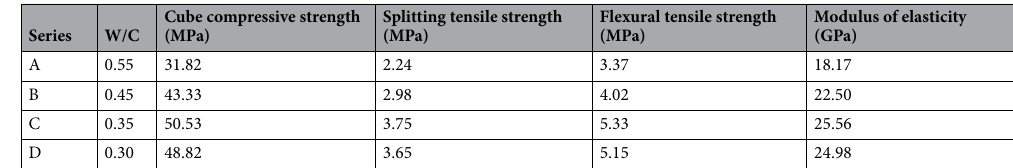
Table 7. Test results for main mechanical properties of CGCLAC at 28 days.